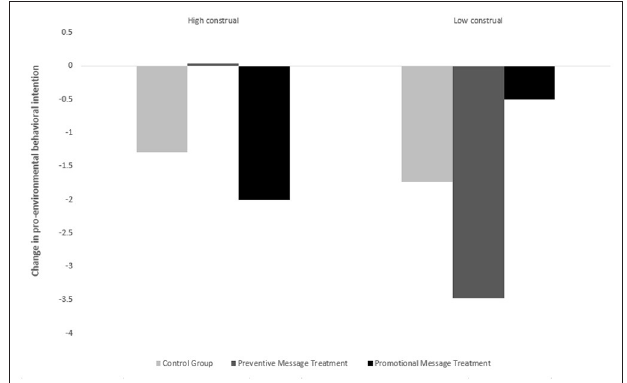
FIGURE 3 | Change in climate change risk